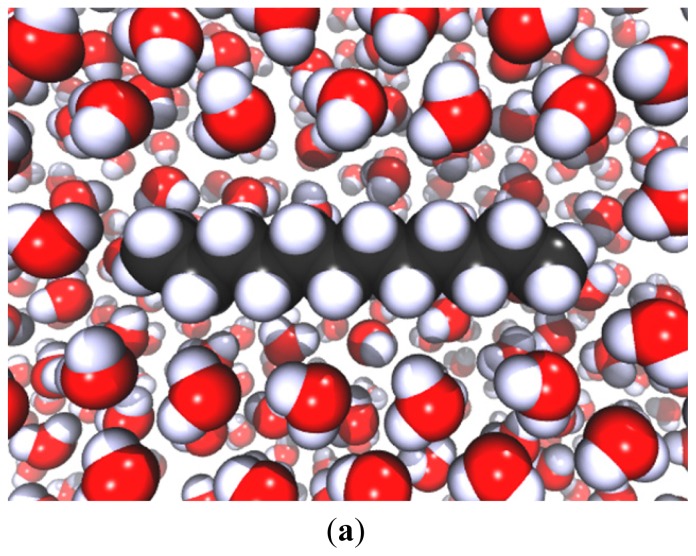
(a) Molecules or parts of molecules that have low or no affinity for water are called hydrophobic. These are usually composed of hydrocarbons that lack O or N or other polar groups and therefore cannot hydrogen bond or interact easily with water. The water molecules adjacent to hydrophobic domains form ice-like cages that surround the hydrophobic region [379]; (b) Schematic representation of the long-range attraction between hydrophobes initiated by the domains of polarized water (i) and by induced dipoles on the surface of the hydrophobic solutes (ii) (Reproduced by permission of Elsevier [380]).